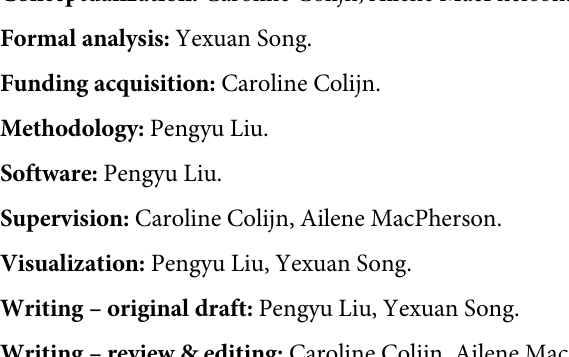
S4 Fig. Characterization of tree edges with intermediate migration rates. (TIFF) S5 Fig. Reconstruction accuracy with location-dependent speciation. (TIFF) S6 Fig. Effect of over/under-sampling recent migrants with different proportions of loca- tion-A tips. (TIFF) S7 Fig. Types and counts of KMEs. (TIFF) S8 Fig. Reconstruction accuracy of KME. (TIFF) S9 Fig. Ancestral state reconstruction of Ebolavirus trees with Sierra Leone downsampled. (TIFF) S10 Fig. Ancestral state reconstruction of Ebolavirus trees with Guinea downsampled. (TIFF) S11 Fig. Reconstruction accuracy of trees of extinct lineages trees versus trees simulated from a birth-death-sampling process. (TIFF) S12 Fig. Accuracy of root reconstruction depends on tree shape. (TIFF) S13 Fig. Accuracy of root reconstruction depends on migration rate.